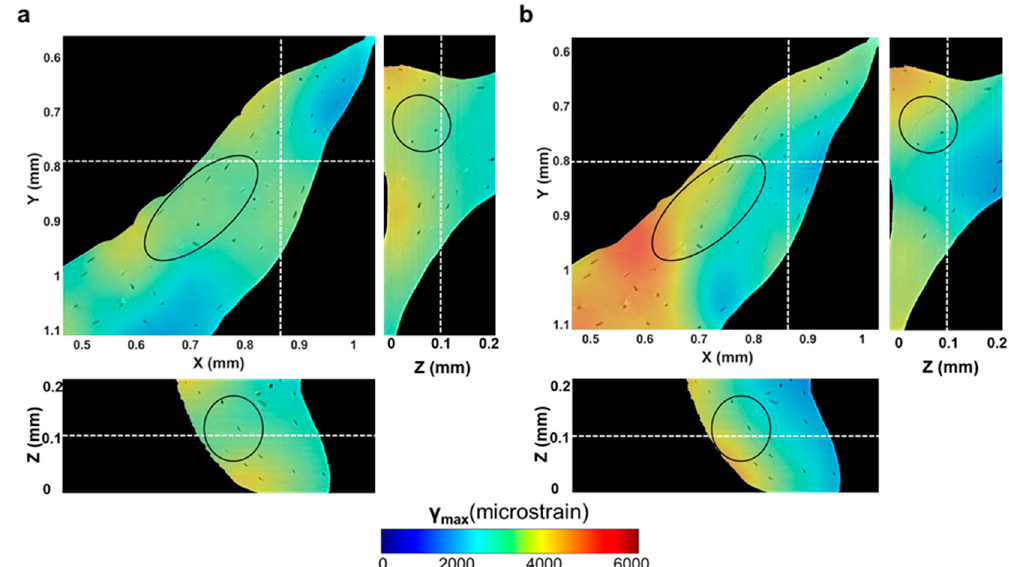
Figure 10. DVC-computed maximum shear strain ( γ max ) through the region of interest analysed around the microcracked area ( a ) before (fourth tomogram) and ( b ) after cracking was visible (fifth tomogram). Oval regions highlight damaged areas of bone tissue, which correspond to an increase in shear strain values before and after cracking. High discontinuities in shear strains were identified in the damage region ( b ), which may suggest the direction of crack propagation.